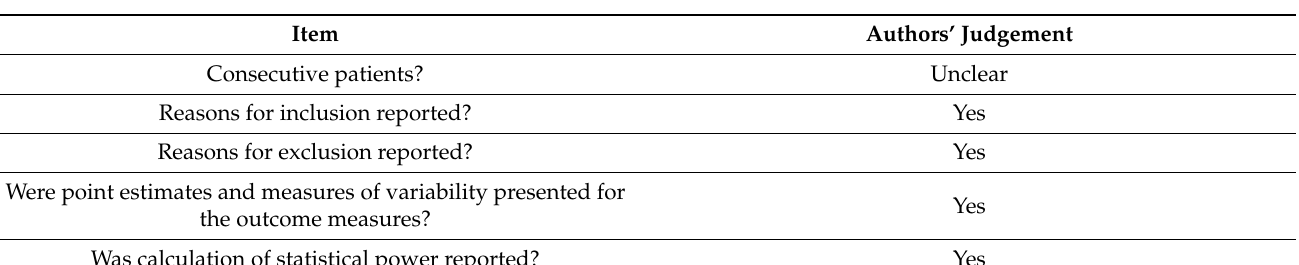
Table A8. Quality assessment.